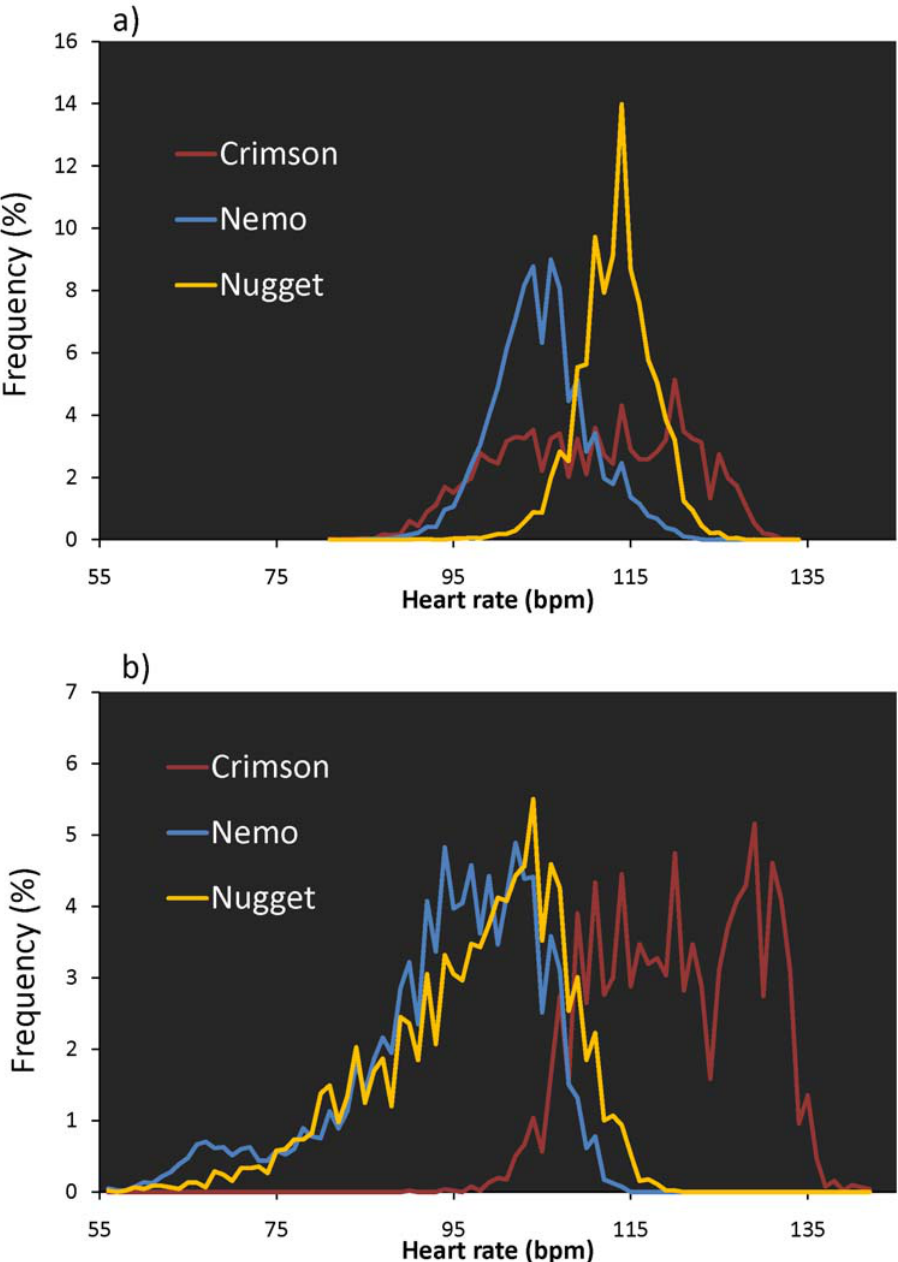
Figure 3. Heart rates recorded during periods of complete inactivity over a) the day (1:00–6:00 PM) and b) the evening (6:00–10:00 PM) of the experiment for the two koalas in contact with tourists (Nugget and Crimson) and the koala without human contact (Nemo).